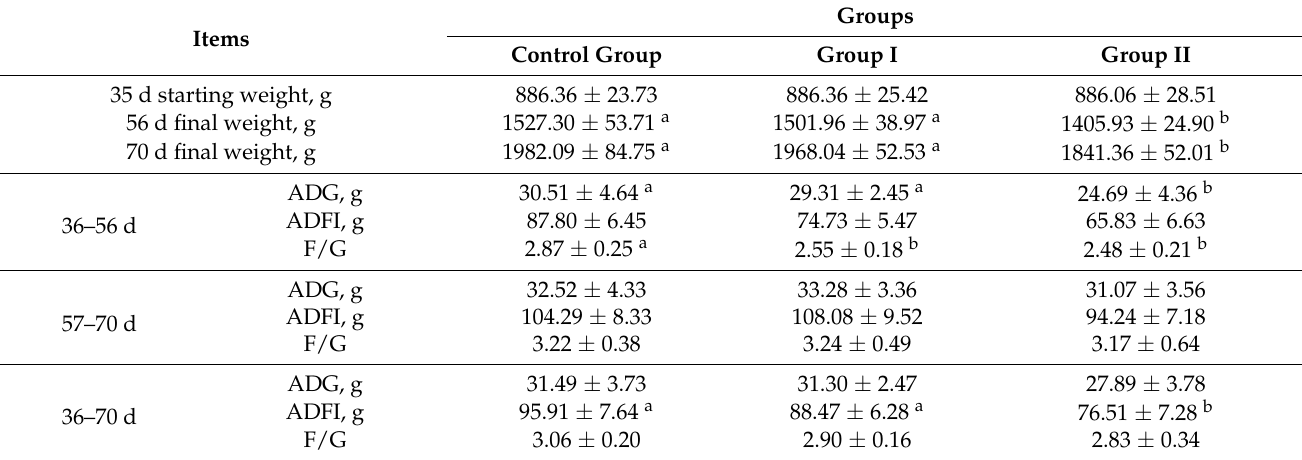
Table 3. Effects of feed restriction and compensation on growth performance of